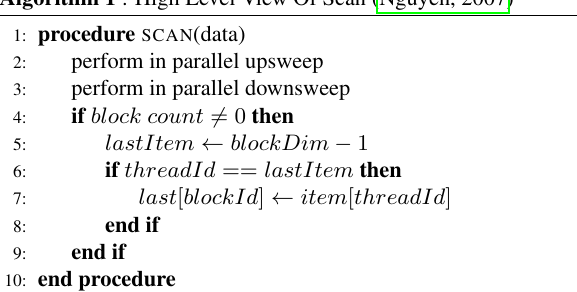
Figure 3. Illustration of lookup